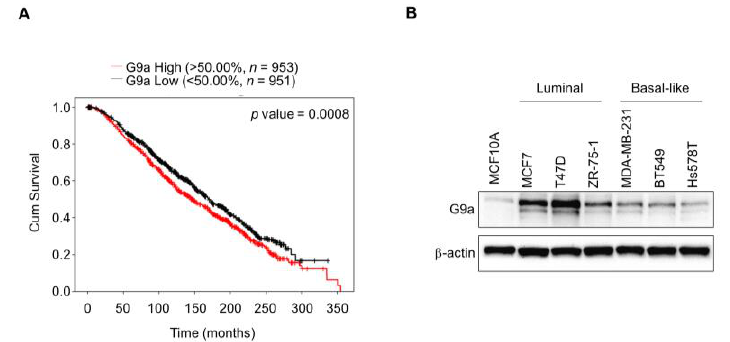
Figure 1. G9a expression influences survival outcomes of breast cancer patients. ( A ) Survival rate of breast cancer patients was reduced in the group with higher G9a expression. ( B ) Among several breast cancer cell lines, no type-dependent differences in G9a expression were found.